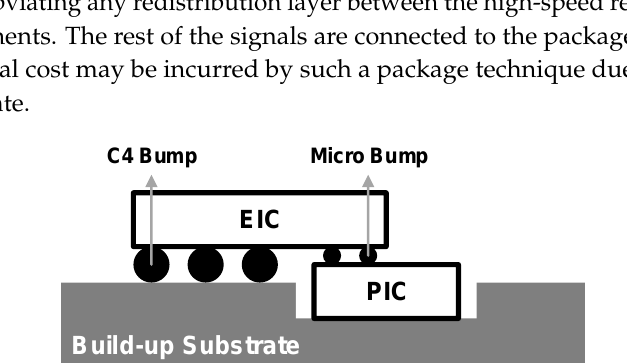
Figure 15. Implementation of 2-D array of EPIC [55].